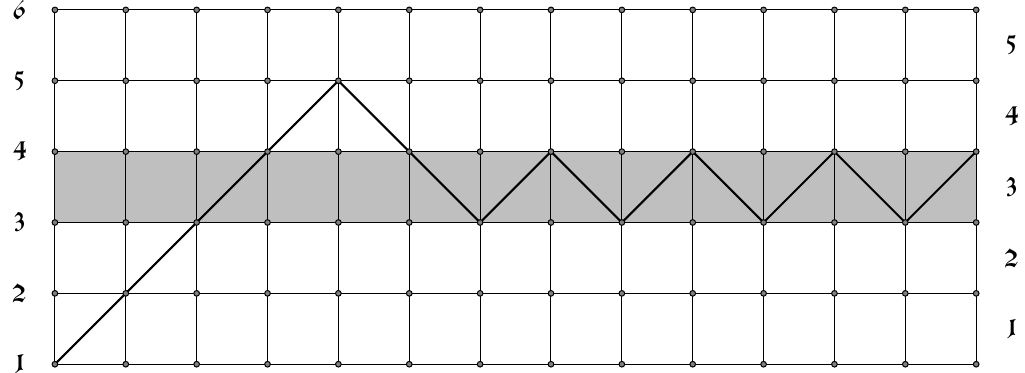
Figure 9 . A non-minimal path in the restricted solid-on-solid model L 2 ; 7 with a peak at ( x; y ) = (0 ; 4) of weight 4.